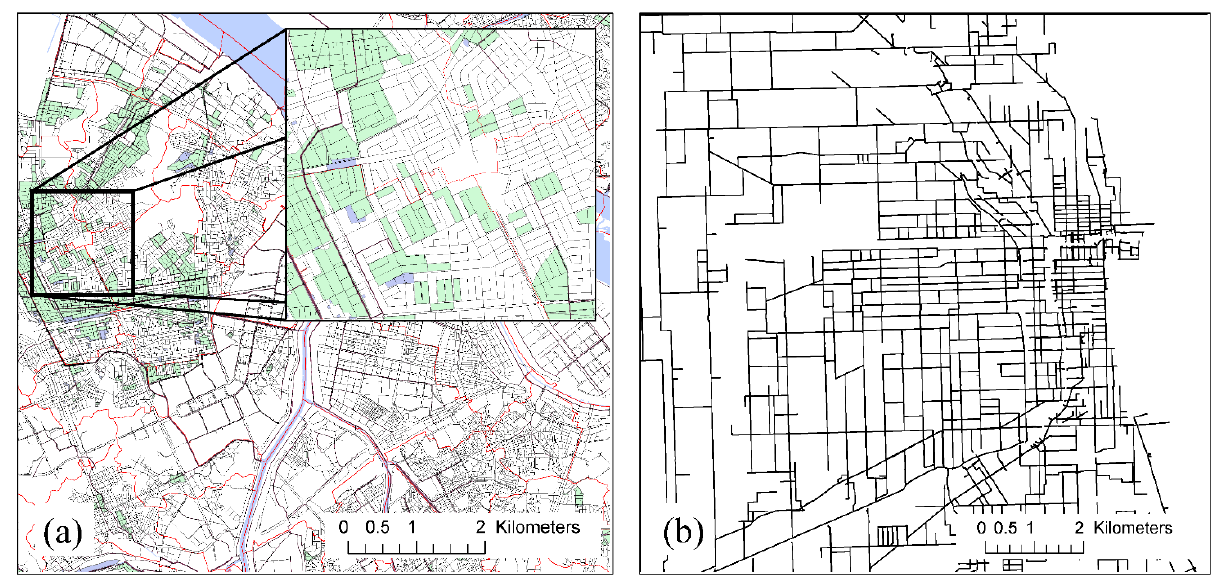
Figure 1. Drainage networks in urban catchments: ( a ) Mokdong area in Seoul, South Korea near the Han River; ( b ) downtown area of Chicago, USA near Lake